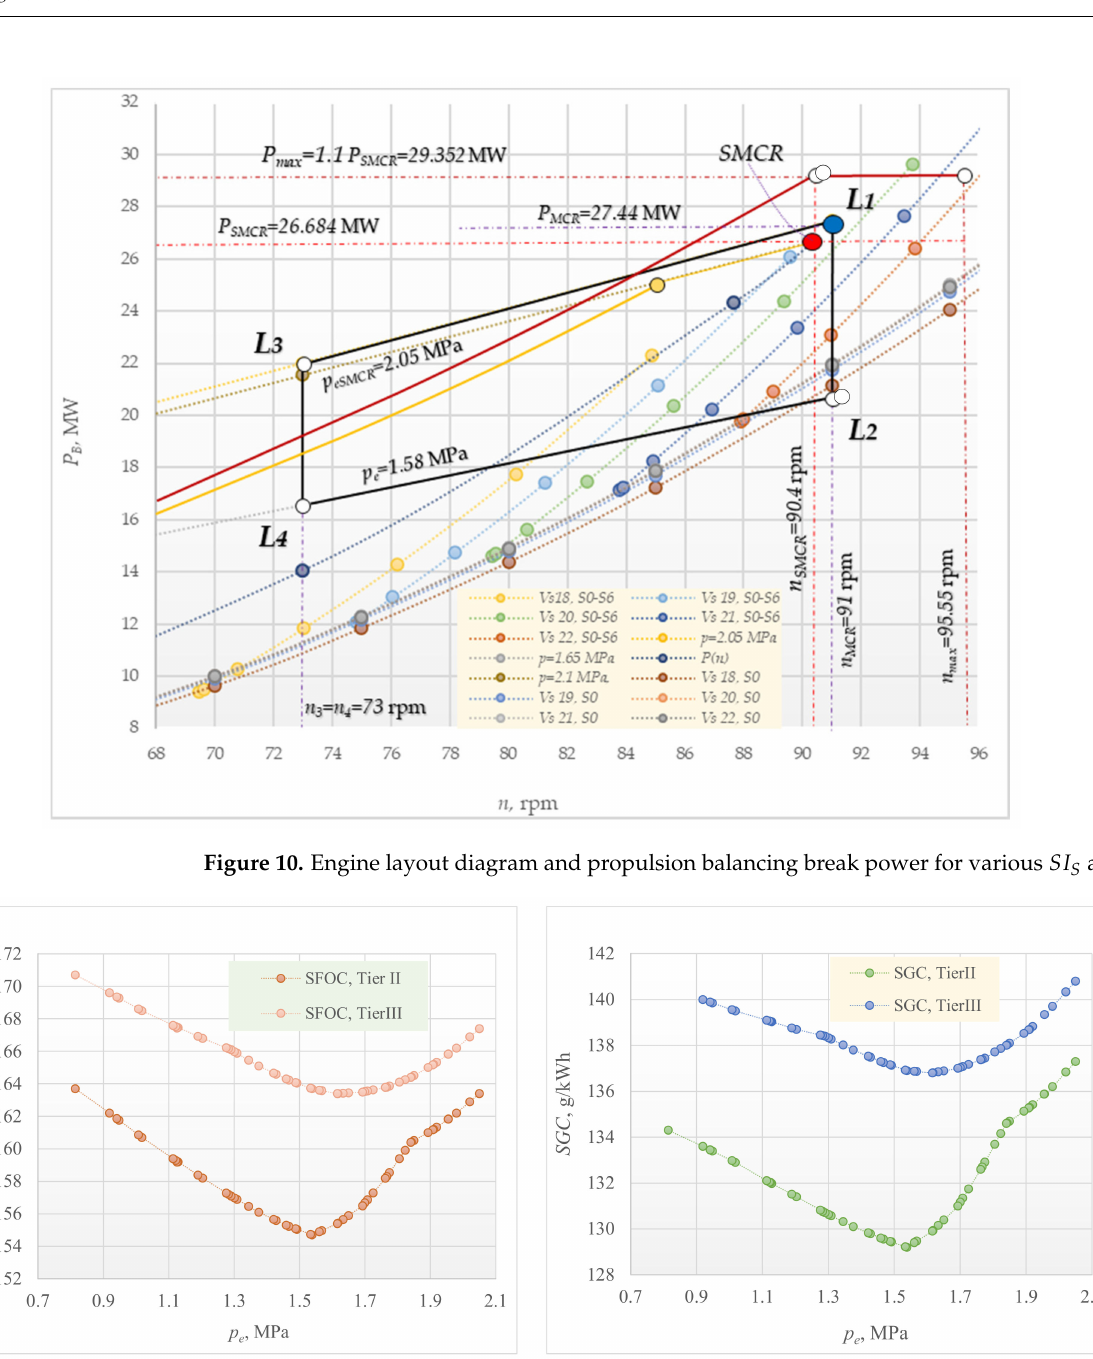
Figure 11. SFOC ( left ) and SGC ( right ) for Tier II and Tier III